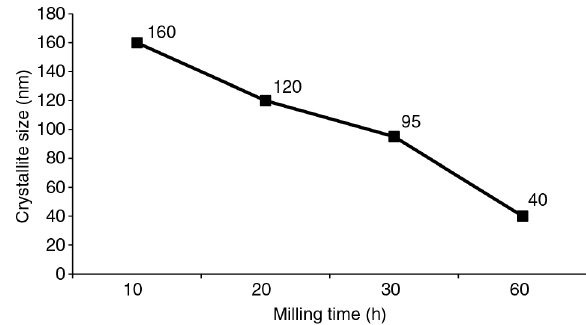
Figure 2: Crystallite size of mixture powders as a function of milling time.